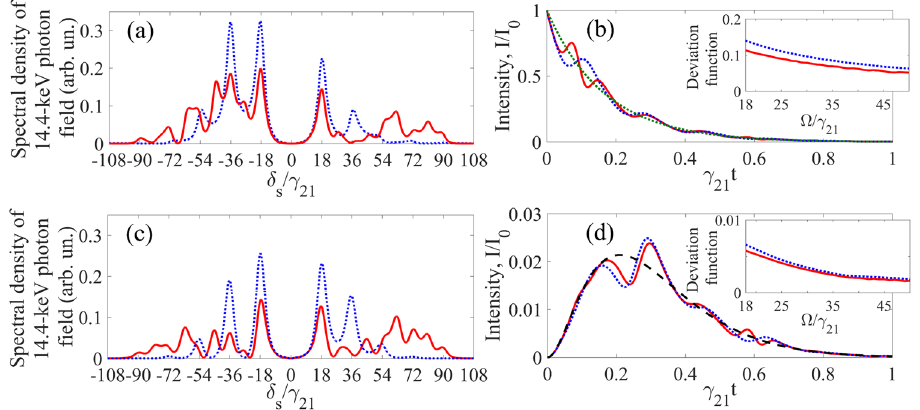
Figure 8. (Color online) The spectrum of the transmitted single-photon wave packet with Lorentz (a) and Lorentz-squared (c) spectral shape in the absorber reference frame for the case of single-tone vibration (blue dotted curve) and dual-tone vibration (red solid curve). The blue dotted curve in (a) is the same as the red curve 2 , L ) in Fig. 3. The blue dotted curves in (a) and (c) are plotted as the normalized function given by ˜ E ′ S (δ S 2 , ω π Eq. (9a), where ˜ E S (δ S ) is determined by Eq. (18) or Eq. (31) at ϑ (cid:31) (cid:31) SC = ω 21 , p = p 1 for Lorentzian = (cid:31) (cid:31) 3 γ 21 , and for Lorentz-squared photon, (c) , with � 0.4 γ 4.7 γ 21 of each line in photon, (a) , with γ S (cid:31) (cid:31) S and γ S = = = (cid:31) 18 (corresponding to � 10.2 MHz ) and T 5 , γ 21 ( 2 π) the doublet. The vibration frequency is � M = ≈ = 2 0 . The red solid curves in (a) and (c) are plotted as the normalized function , L ) T e given by Eq. (9a), (cid:31) (cid:31) ˜ E ′ S (δ S = 2 (cid:31) (cid:31) , 0 ) where is determined by Eq. (45) at the same values as for the SMS spectral line. The fundamental (cid:31) (cid:31) ˜ E ′ S (δ S (cid:31) (cid:31) 18 , γ 21 frequency of the dual-tone absorber vibration is the same as that of the single-tone vibration, � (cid:31) (cid:31) = (cid:31) (cid:31) 2 , and ϕ 4 . In panels (b) and (d) , there are the corresponding 3.1 , p 3.8 , ϑ 3 π whereas p H (cid:31) (cid:31) H = π = = = − (cid:31) normalized waveforms of the Lorentz, (b) , and Lorentz-squared, (d) , photon (with deviation function (Eq. 24) (cid:31) (cid:31) in the insets) transmitted through the single-tone vibrating absorber [the blue dotted curves corresponding to the blue spectra in (a) and (c) ] and dual-tone vibrating absorber [the red solid curves corresponding to the red ( 8 π) ] given by I 0 [where I 0 cE 2 0 spectra in (a) and (c) ]. The curves are plotted as the function I out ( t ) = Eq. (cid:31) (cid:31)